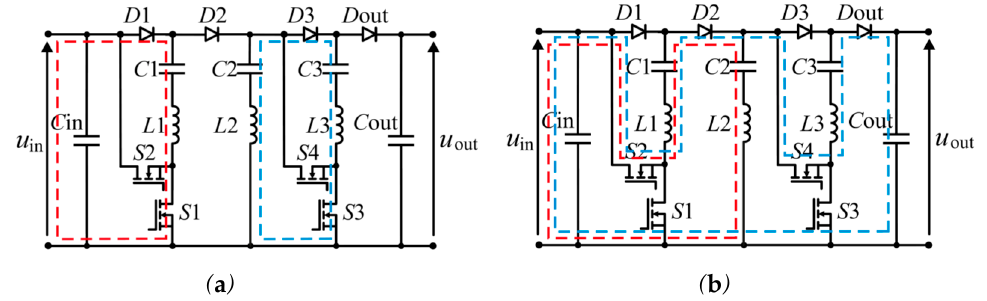
Figure 11 . Current paths in the LCSCVMa: ( a ) in the stage 1 and ( b ) in the stage 2. Figure 11. Current paths in the LCSCVMa: ( a ) in the stage 1 and ( b ) in the stage